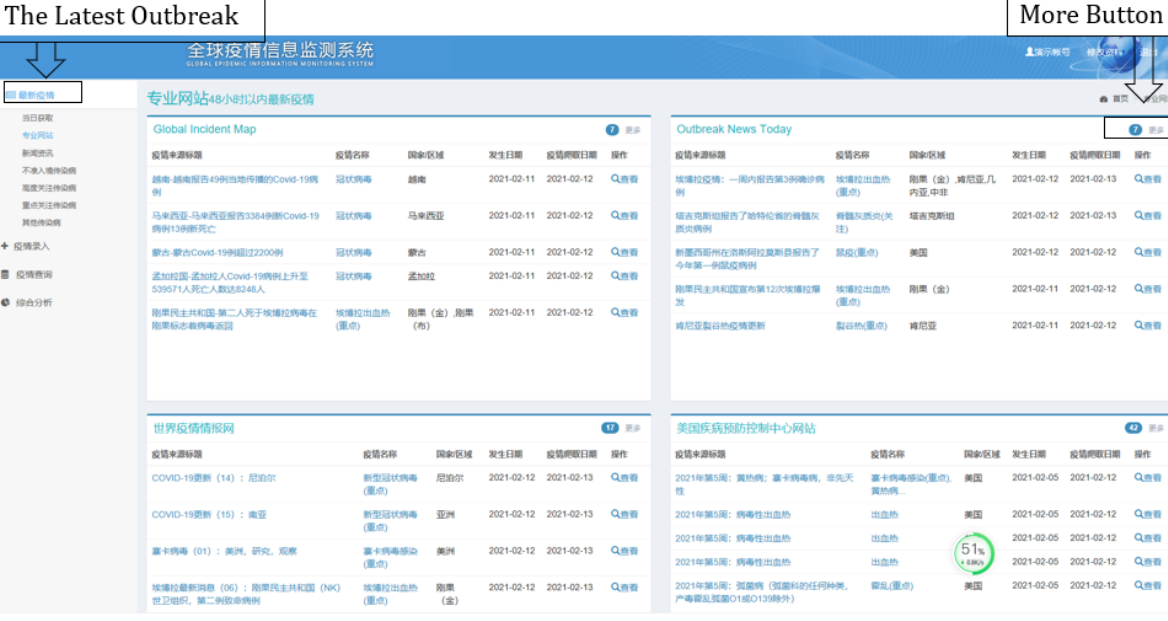
Figure 4. Detailed information provided by the Global Infectious Diseases Epidemic Information Monitoring